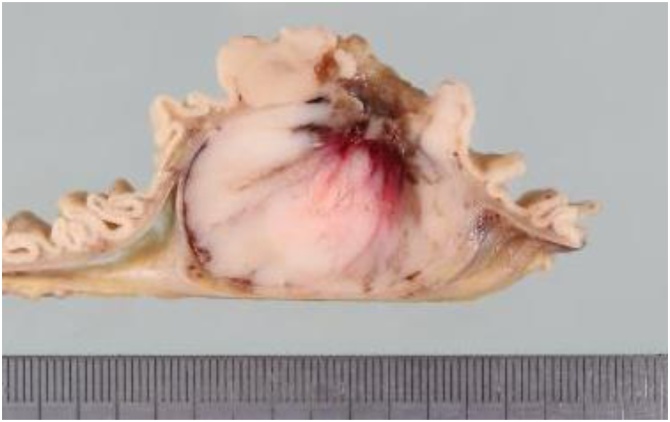
The cut section of the gross specimen shows an intramural mass, which measures 40 × 40 mm. A depressed ulcerative lesion is identified.